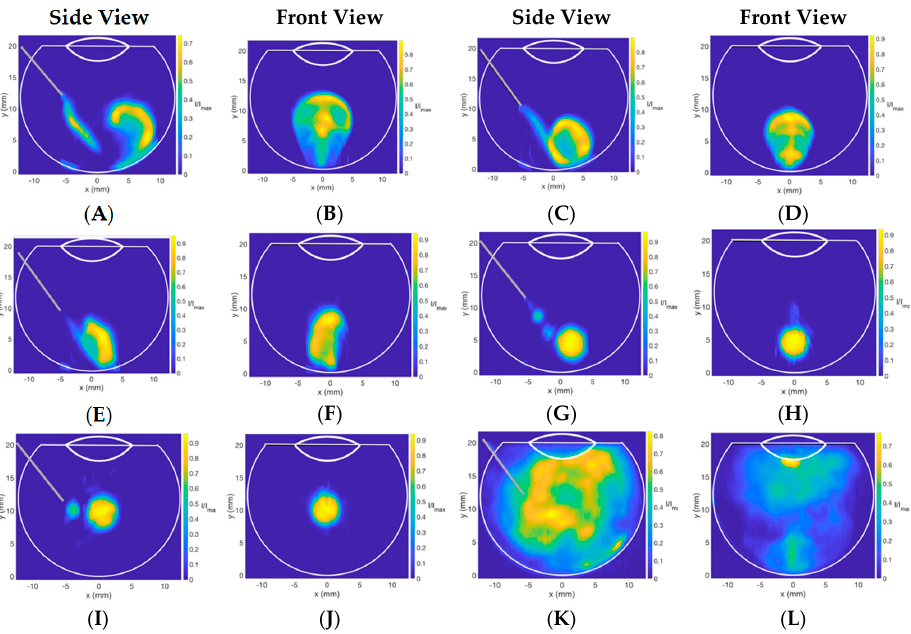
Figure 9. Contour plot of the dye concentration injected in different vitreous substitutes at high Re (677 ± 175), fast injection times (<1 s). ( A , B ) 1.0 mg/mL HA, ( C , D ) 2.0 mg/mL HA, ( E , F ) 3.0 mg/mL HA, ( G , H ) S500, ( I , J ) S1000 and ( K , L ) BSS. The fast injection rate resulted in fluid engulfment, increasing the surface area and promoting mixing and diffusion.